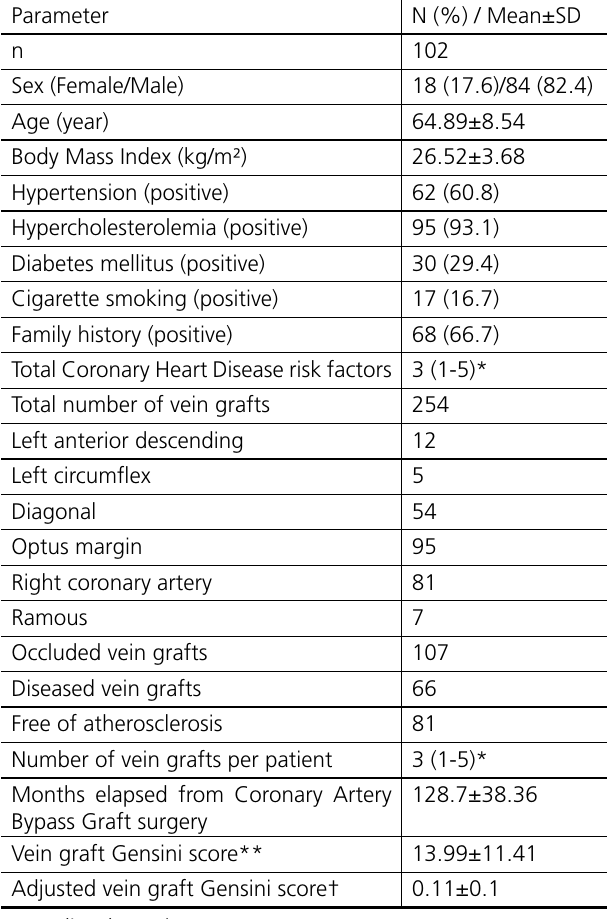
Table 2. Genotype and allele frequencies of ACE I/D polymorphism in studied patients with vein graft atherosclerosis .